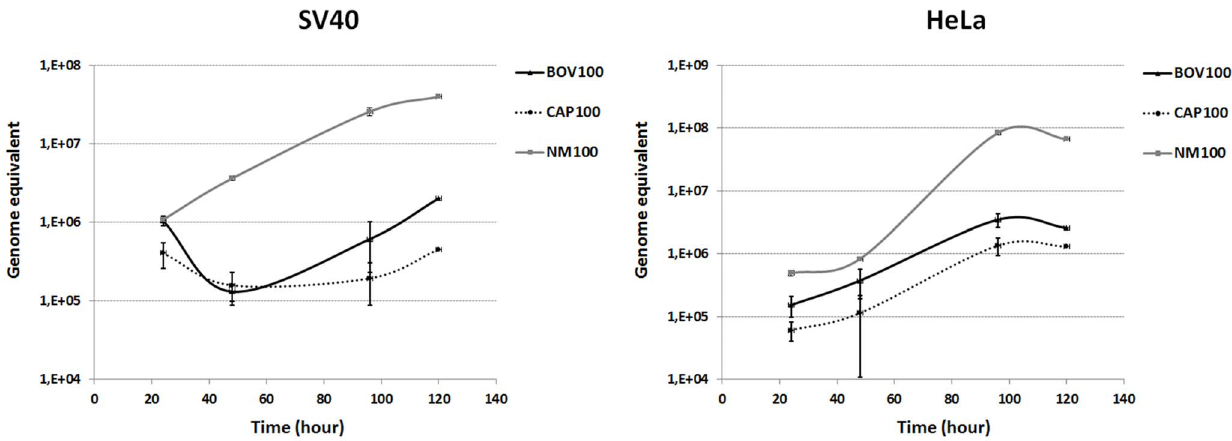
Figure 3. Growth curves of NMI, CbBEB1 and CbBEC1 in HeLa and SV40 cells. Cells were infected at 100 M.O.I. for 24 hours. Infected cells were then washed and grown in gentamicin-containing medium for 96 additional hours. At fixed time-points, deionized water was added and cells lysed by a 30-min incubation at 82 u C. C. burnetii loads were quantified by qPCR on 1:15 dilutions. Each point indicates the average of four independent cultures and its corresponding standard deviation.